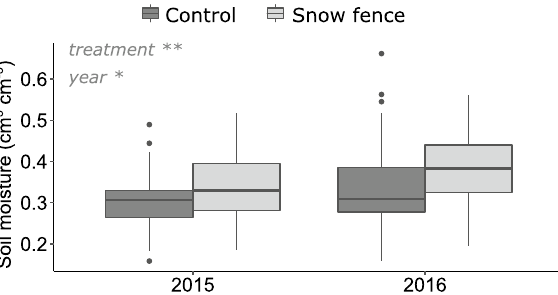
Figure 2. Volumetric soil moisture content (volume water per volume soil sampled) as measured at sampling (early July 2015 and 2016) in unmanipulated, ambient (Control) plots and increased snow depth (Snow fence) plots (n = 11, error bars are standard deviations). Boxes indicate 50% of the central data, the black thick line being the median, black dots are outliers (further than 1.5 times the Box’s range above or below its